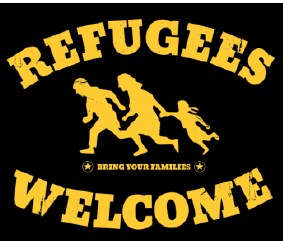
Figure 1. Refugees-welcome logo. Source: Linkes Grafik- archiv